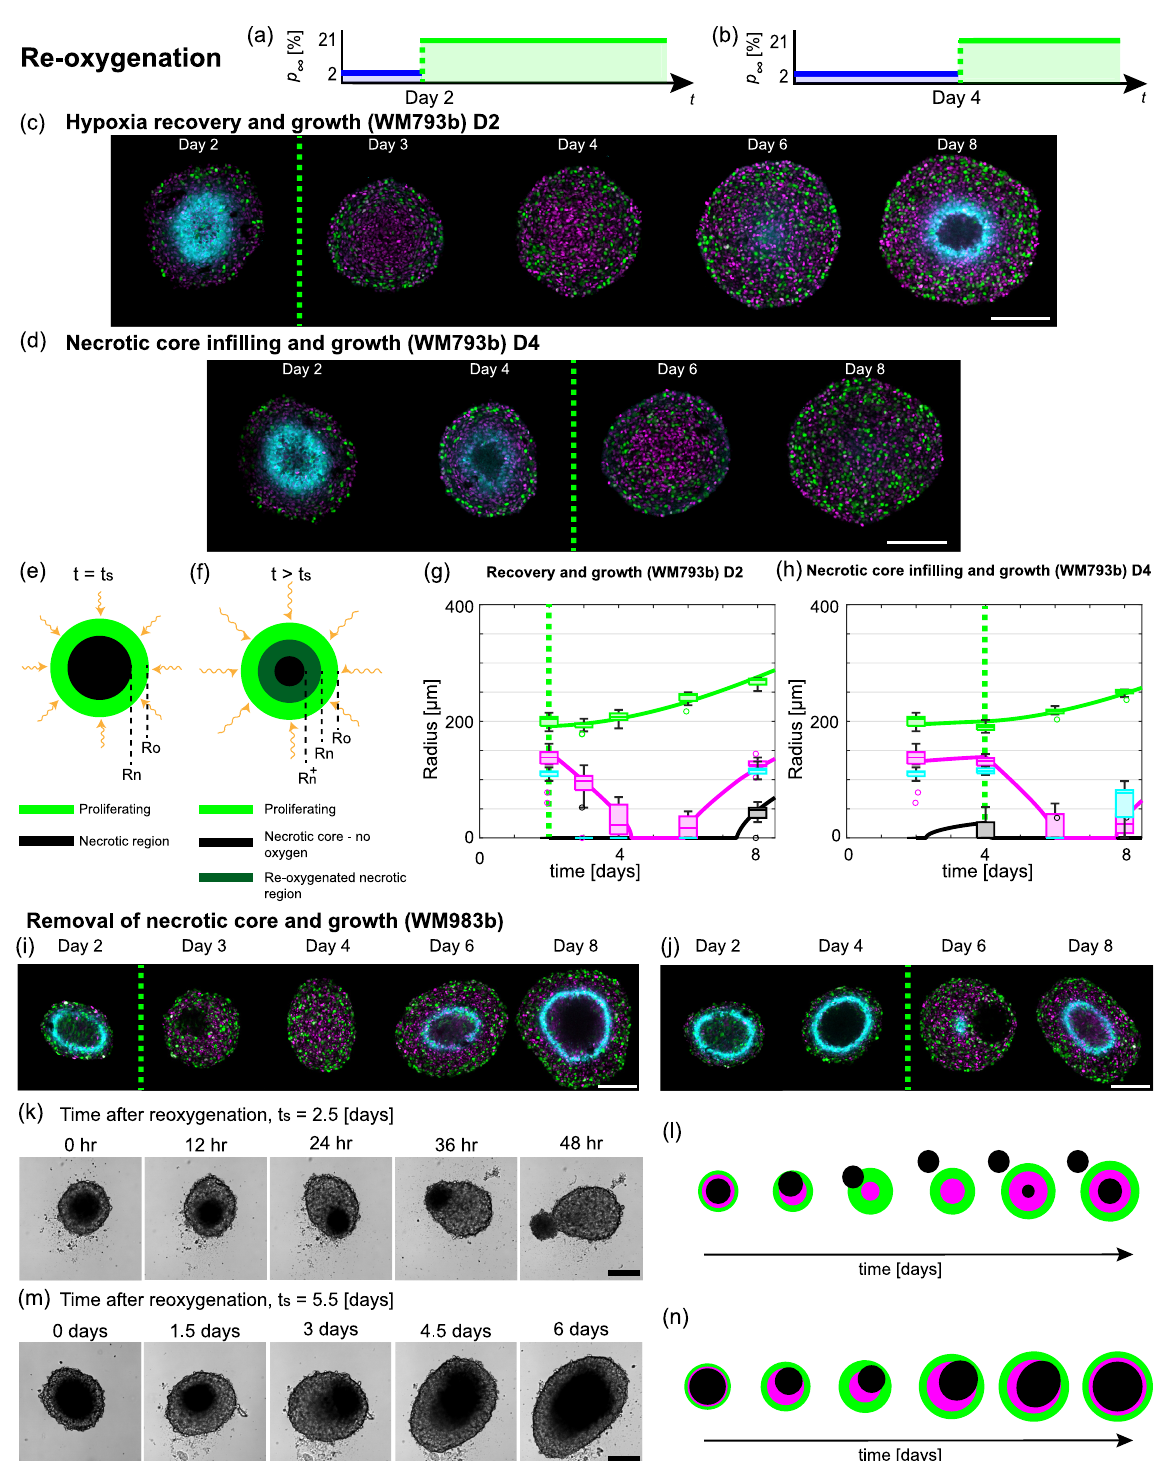
Fig 5. Tumour spheroids exhibit a range of adaption mechanisms in response to re-oxygenation. (a,b) Schematics for re-oxygenation experiments, where the external oxygen environment switches from hypoxia to normoxia at (a) t s = 2 [days] and (b) t s = 4 [days]. (c,g) Hypoxia recovery and growth for WM793b cell line with t s = 2 [days] with (c) experimental images and (g) radial measurements. (d,h) Necrotic core infilling and growth for WM793b cell line with t s = 4 [days] with (d) experimental images and (h) radial measurements. Green dashed line in (c, d,g,h,i,j) indicate t s . Colours in (g,h) R o ( t ) (green), R i ( t ) (magenta), R n ( t ) (black), and R p ( t ) (cyan). (e,f) Schematics for tumour